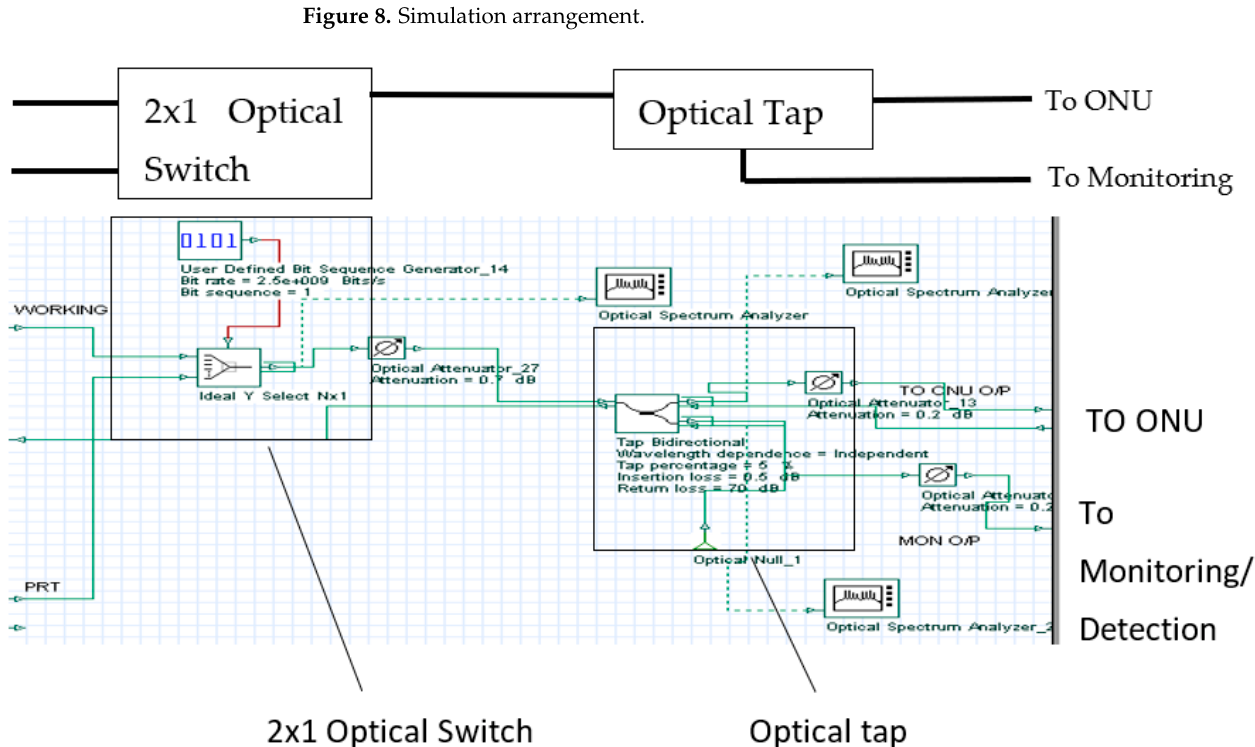
Figure 9. PROMO configuration for simulation.